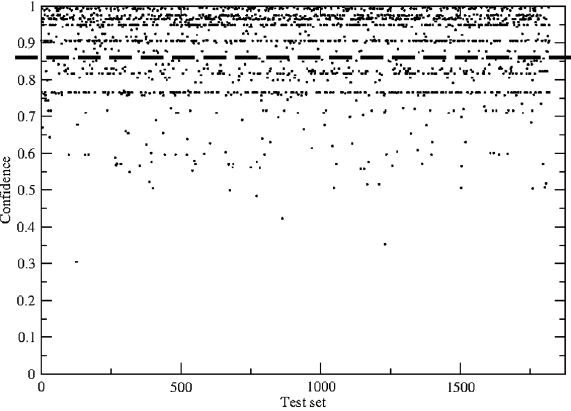
Figure 7. Prediction confidence of test set calculated according to Eqn (8). The dashed line represents the boundary, currently set to